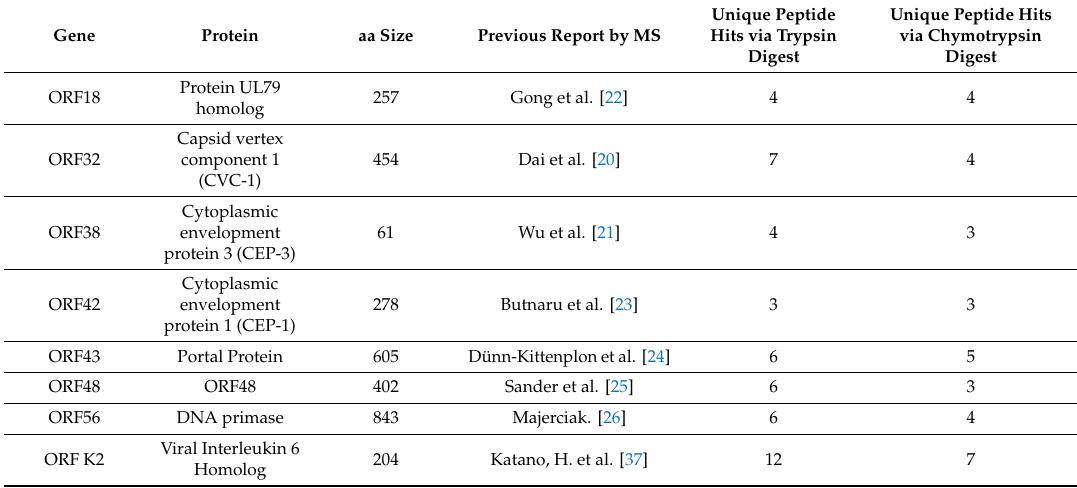
Table 2. Proteins identified by mass spectrometry in our study that were previously reported by other